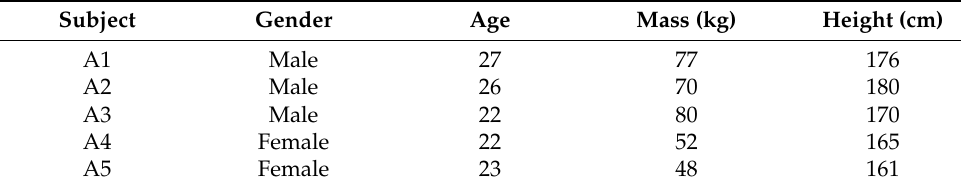
Table 1. The physical parameters of each